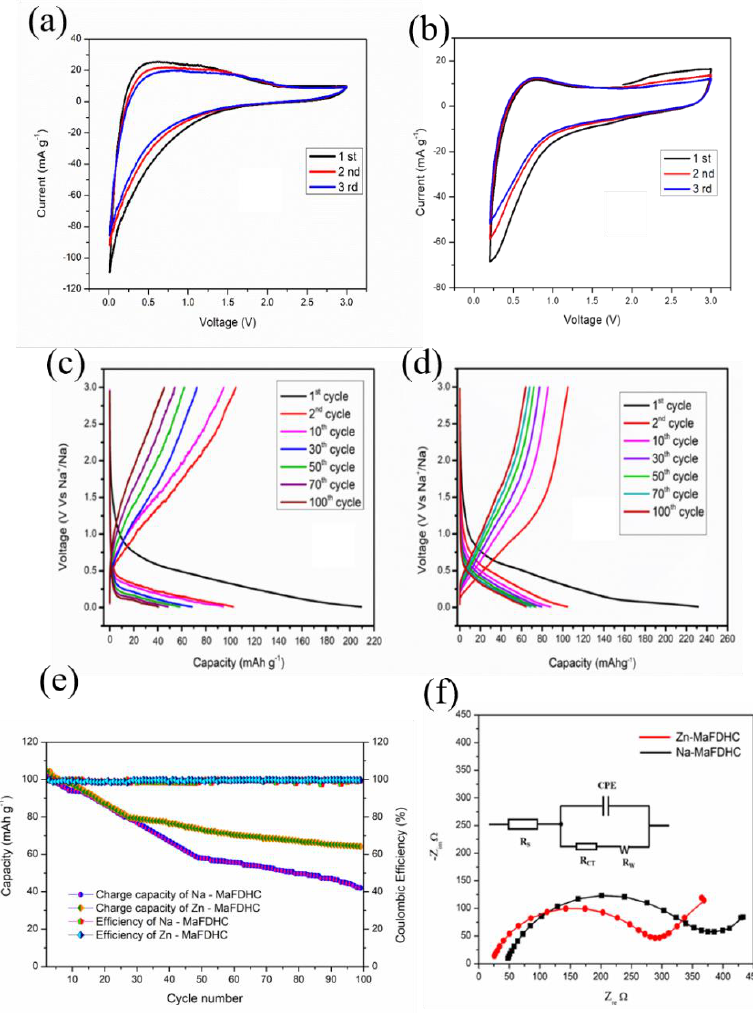
Figure 6. Cyclic Voltametry for ( a ) Na − MaFDHC and ( b ) Zn − MaFDHC. Galvanostatic charge/discharge performance of ( c ) Na − MaFDHC, ( d ) Zn − MaFDHC. ( e ) Cyclic performance and efficiency of MaFDHC cells. ( f ) Nyquist plot of MaFDHC cells.